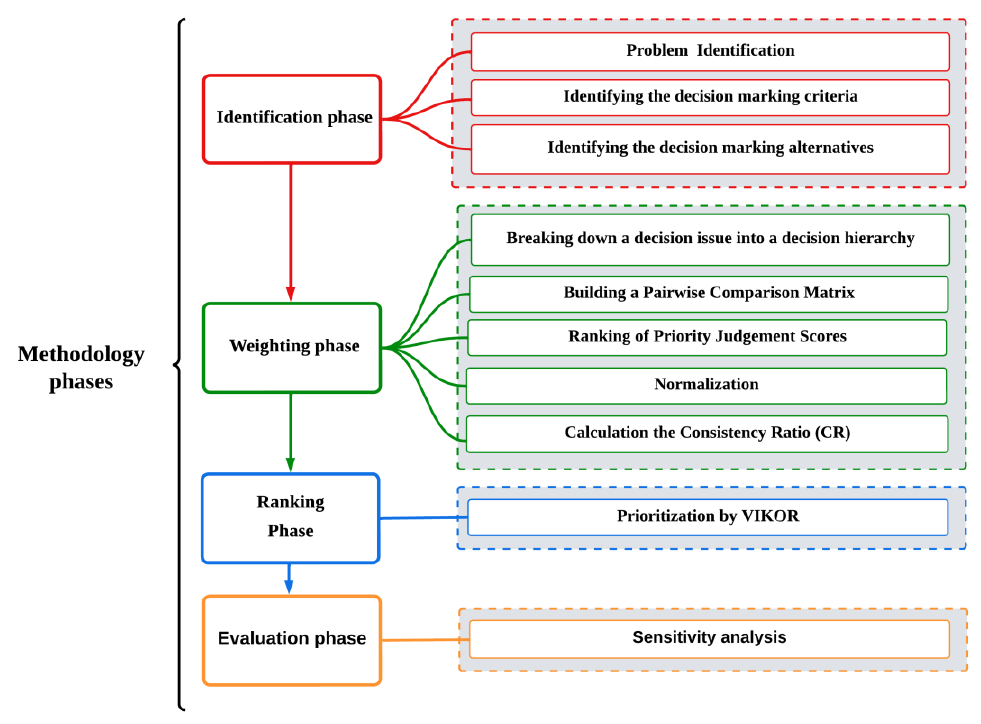
Figure 4. Methodology phases of AHP – VIKOR.